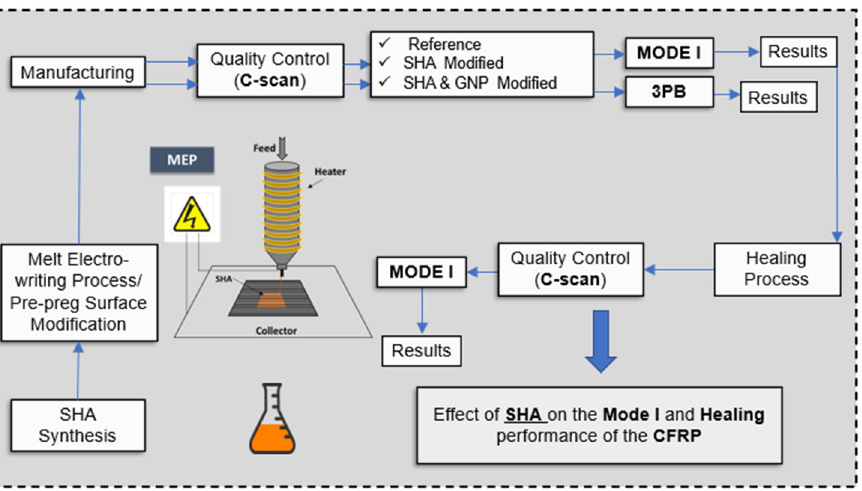
Figure 1. Schematic presentation of the scheduled characterization campaign conducted in the pre- sent